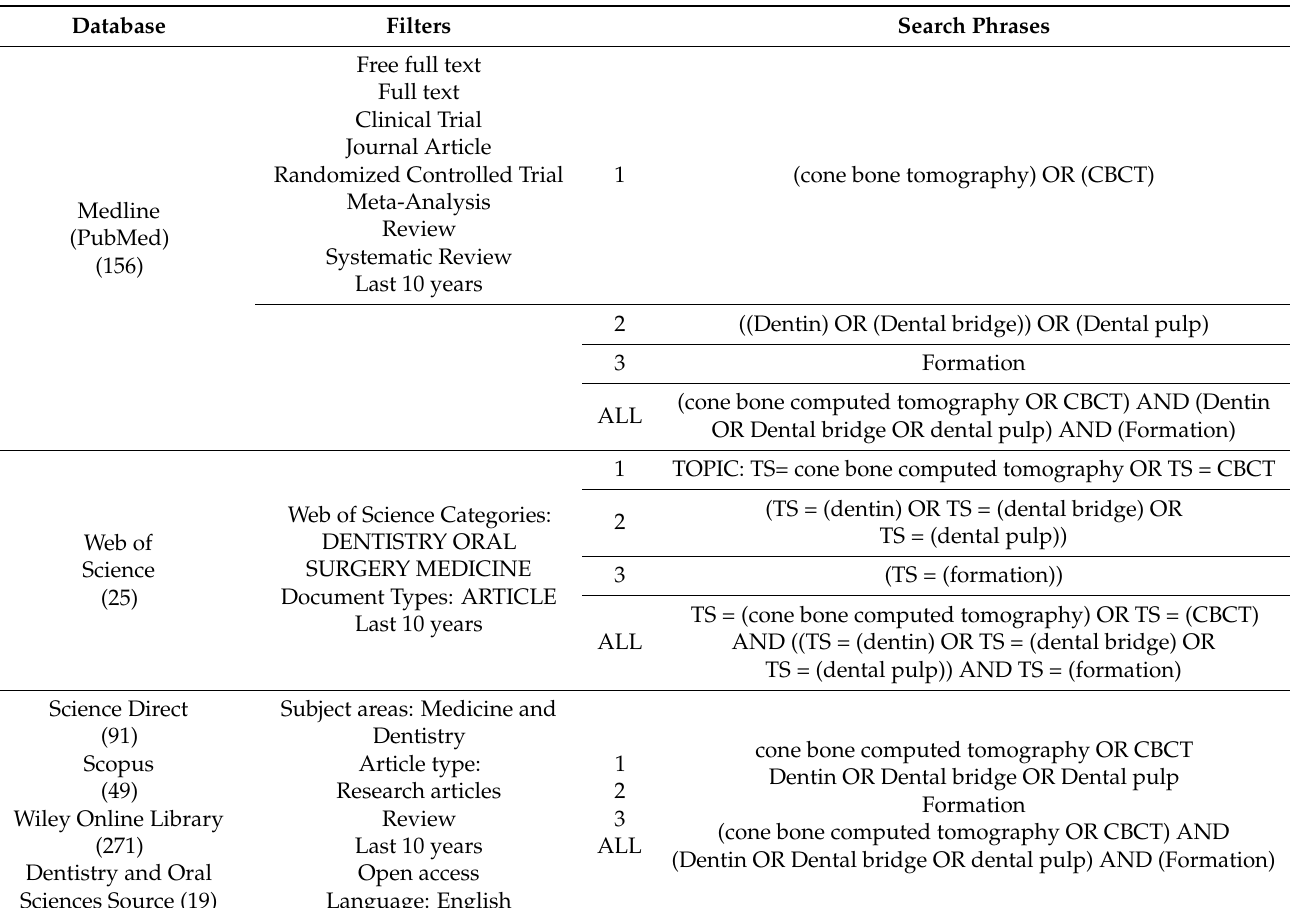
Table 1. The CBCT search